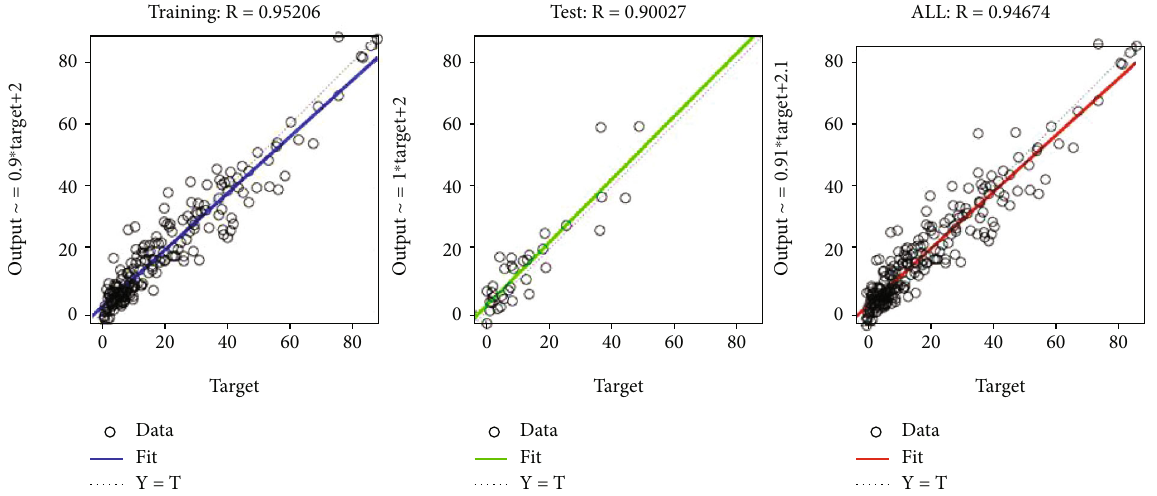
Figure 8: BP neural network fi tting e ff ect